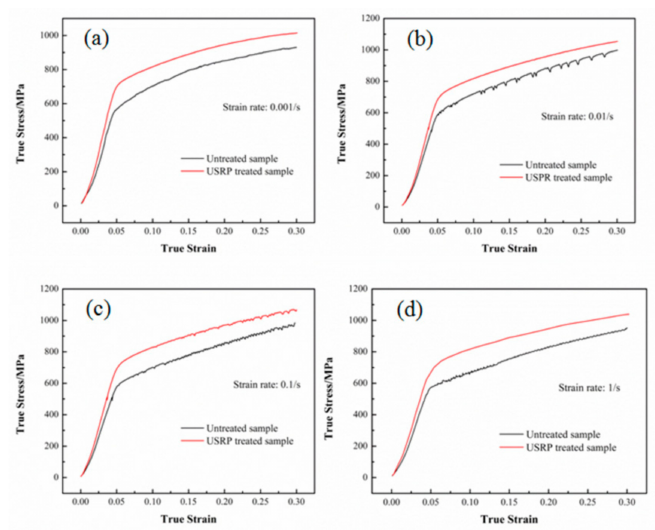
Figure 3. True stress–strain curves of the hot-compressed USRP-treated samples and untreated samples at di ff erent true strain rates: ( a ) 0.001 s − 1 , ( b ) 0.01 s − 1 , ( c ) 0. 1 s − 1 , ( d ) 1 s − 1